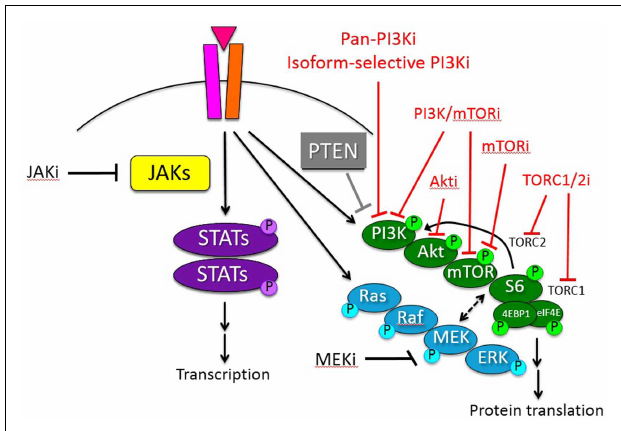
FIGURE 1 | Schema of PI3K/mTOR and other oncogenic signaling pathways in hematologic malignancies . Inhibitors (i) of these signaling proteins under current preclinical or clinical study with potential therapeutic relevance for pediatric hematologic malignancies are delineated. Red = inhibitors of PI3K/mTOR pathway signal transduction